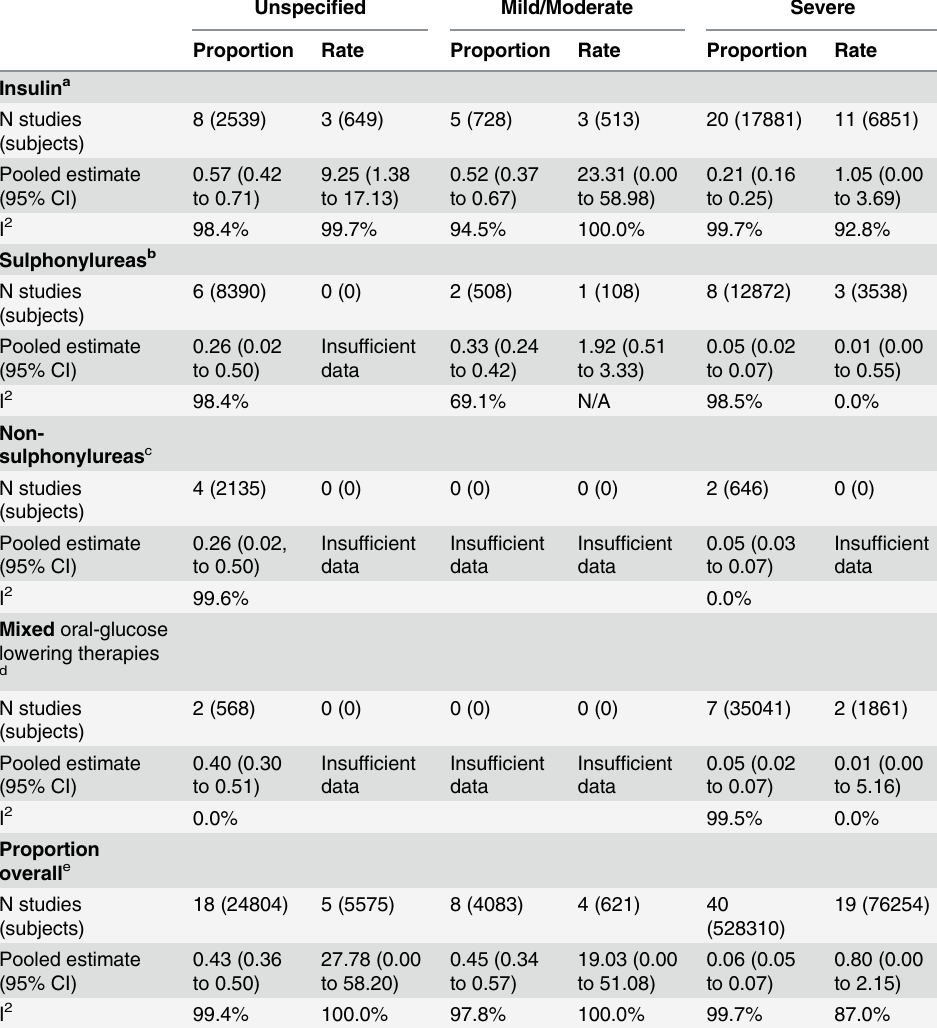
Table 2. Proportion of people experiencing hypoglycaemia and the number of episodes per patient- year by severity and treatment regime. Unspeci fi ed